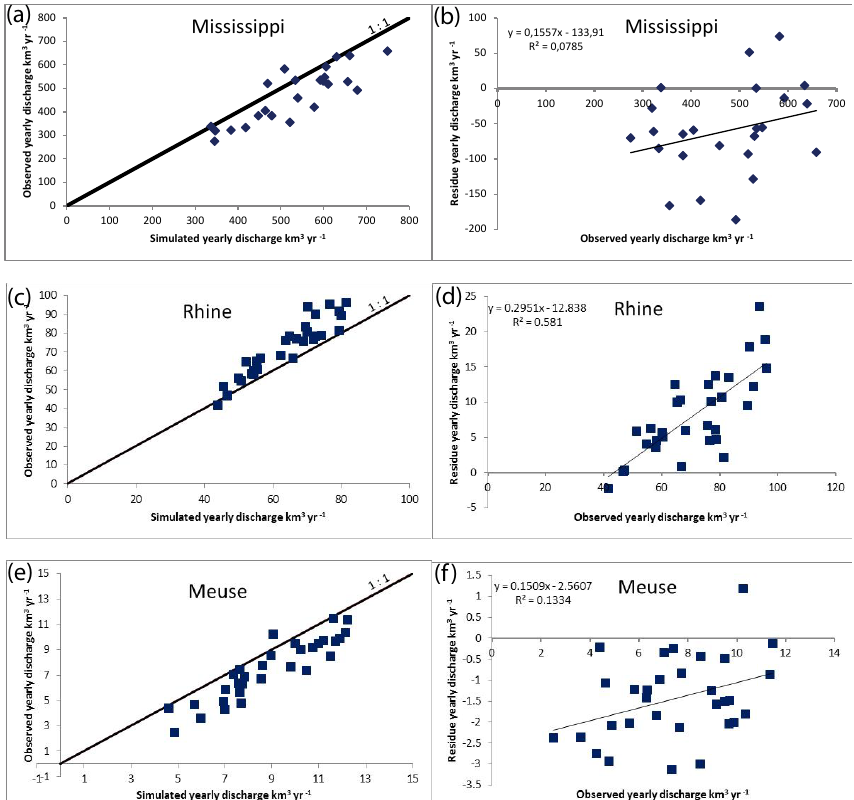
Figure 8. Comparison of simulated and observed annual discharge (left-hand graphs with 1:1 lines) and residues (observation minus simu- lation) vs. observation (right-hand graphs with regression lines) for Mississippi (a, b) , Rhine (c, d) and Meuse (e, f)